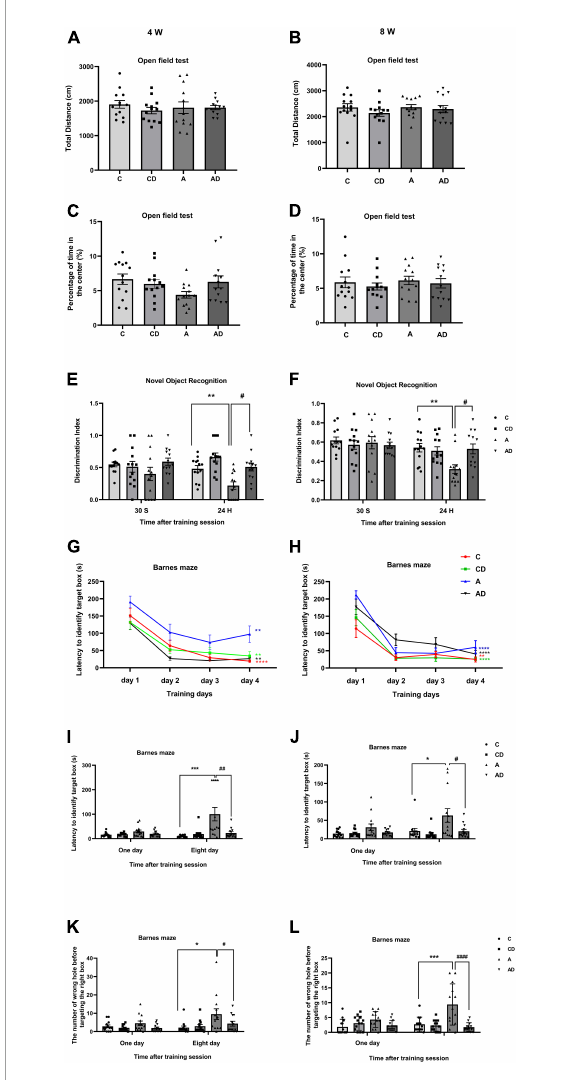
FIGURE3 Behavioral performances of different groups of mice